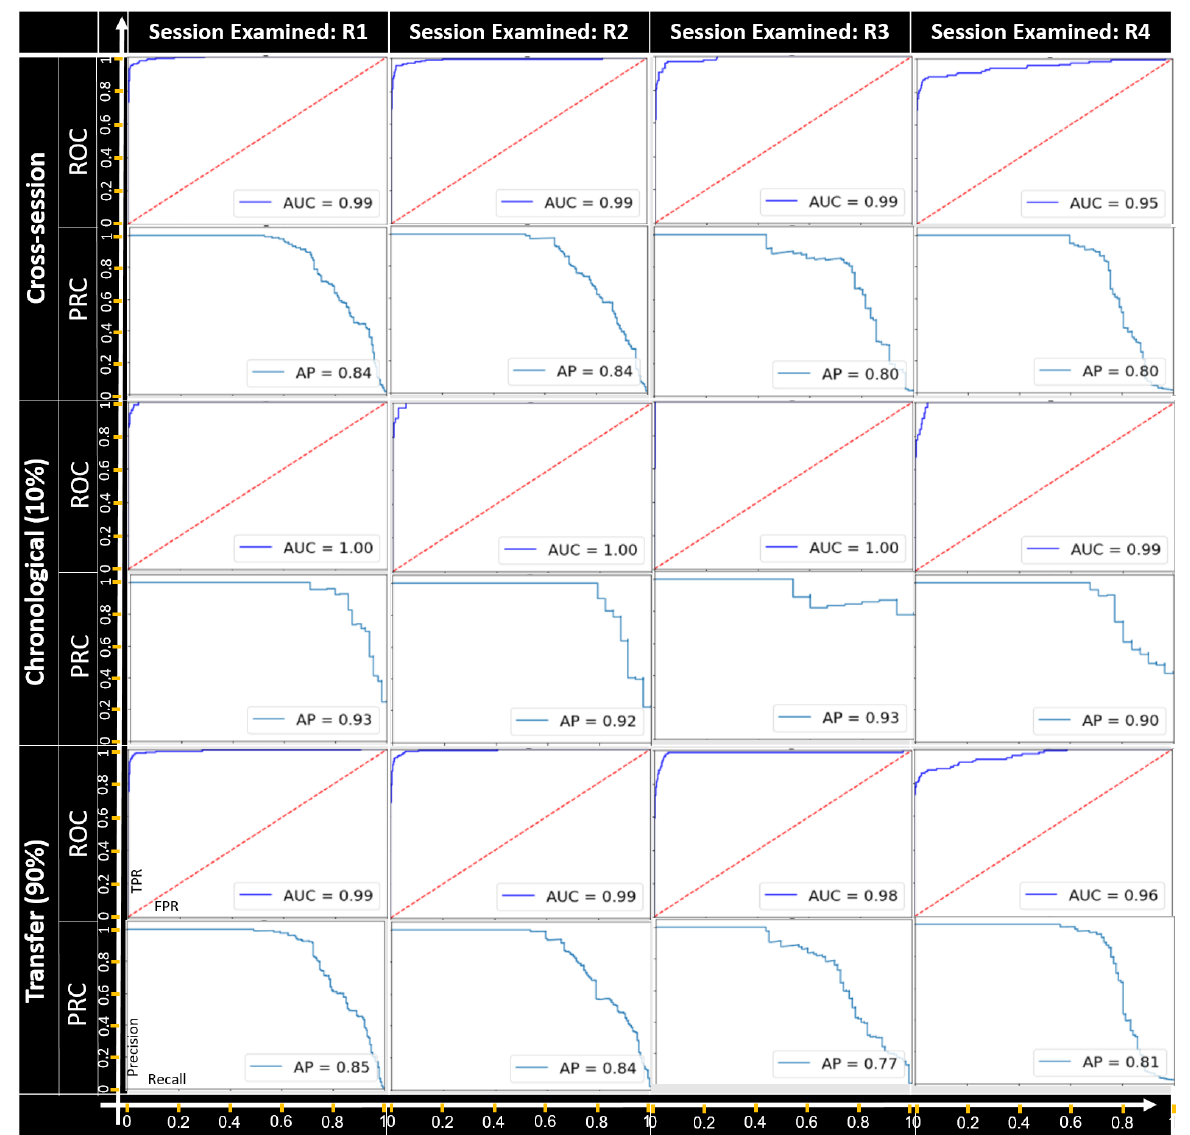
Figure 8. The ROC and PRC curves for the Plot-dropping attack for each recording session